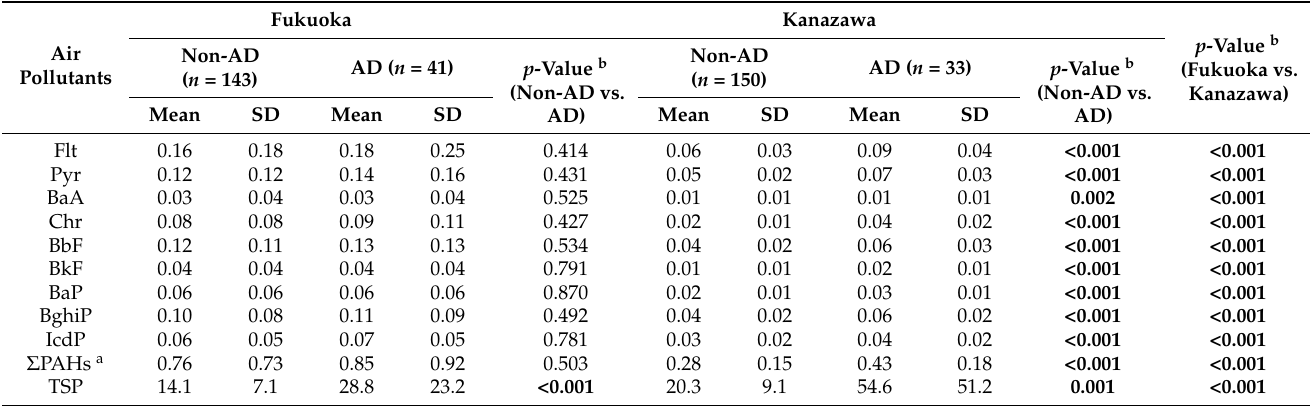
Table 3. Difference between individual PAH and TSP in Fukuoka and Kanazawa in non-AD and AD days.